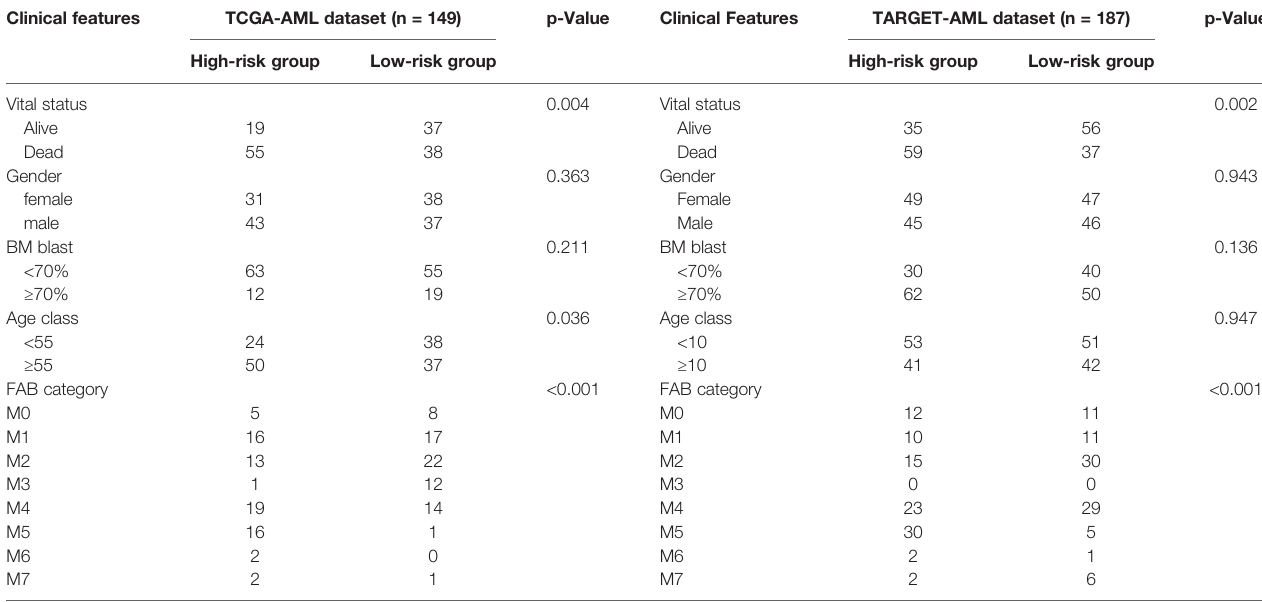
TABLE 1 | Clinical information of